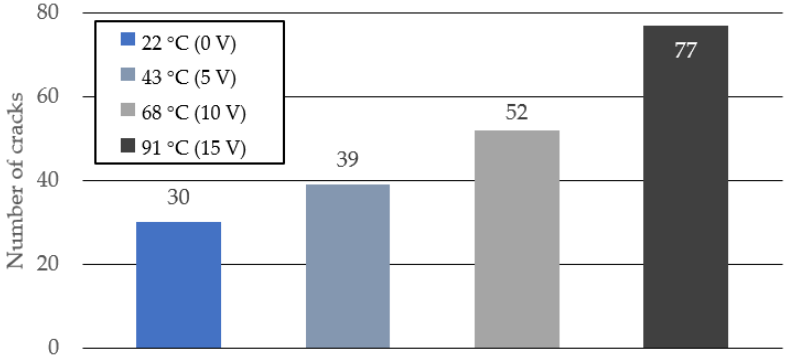
Figure 11. Surface temperatur − shrinkage strain relationship of TCPA.